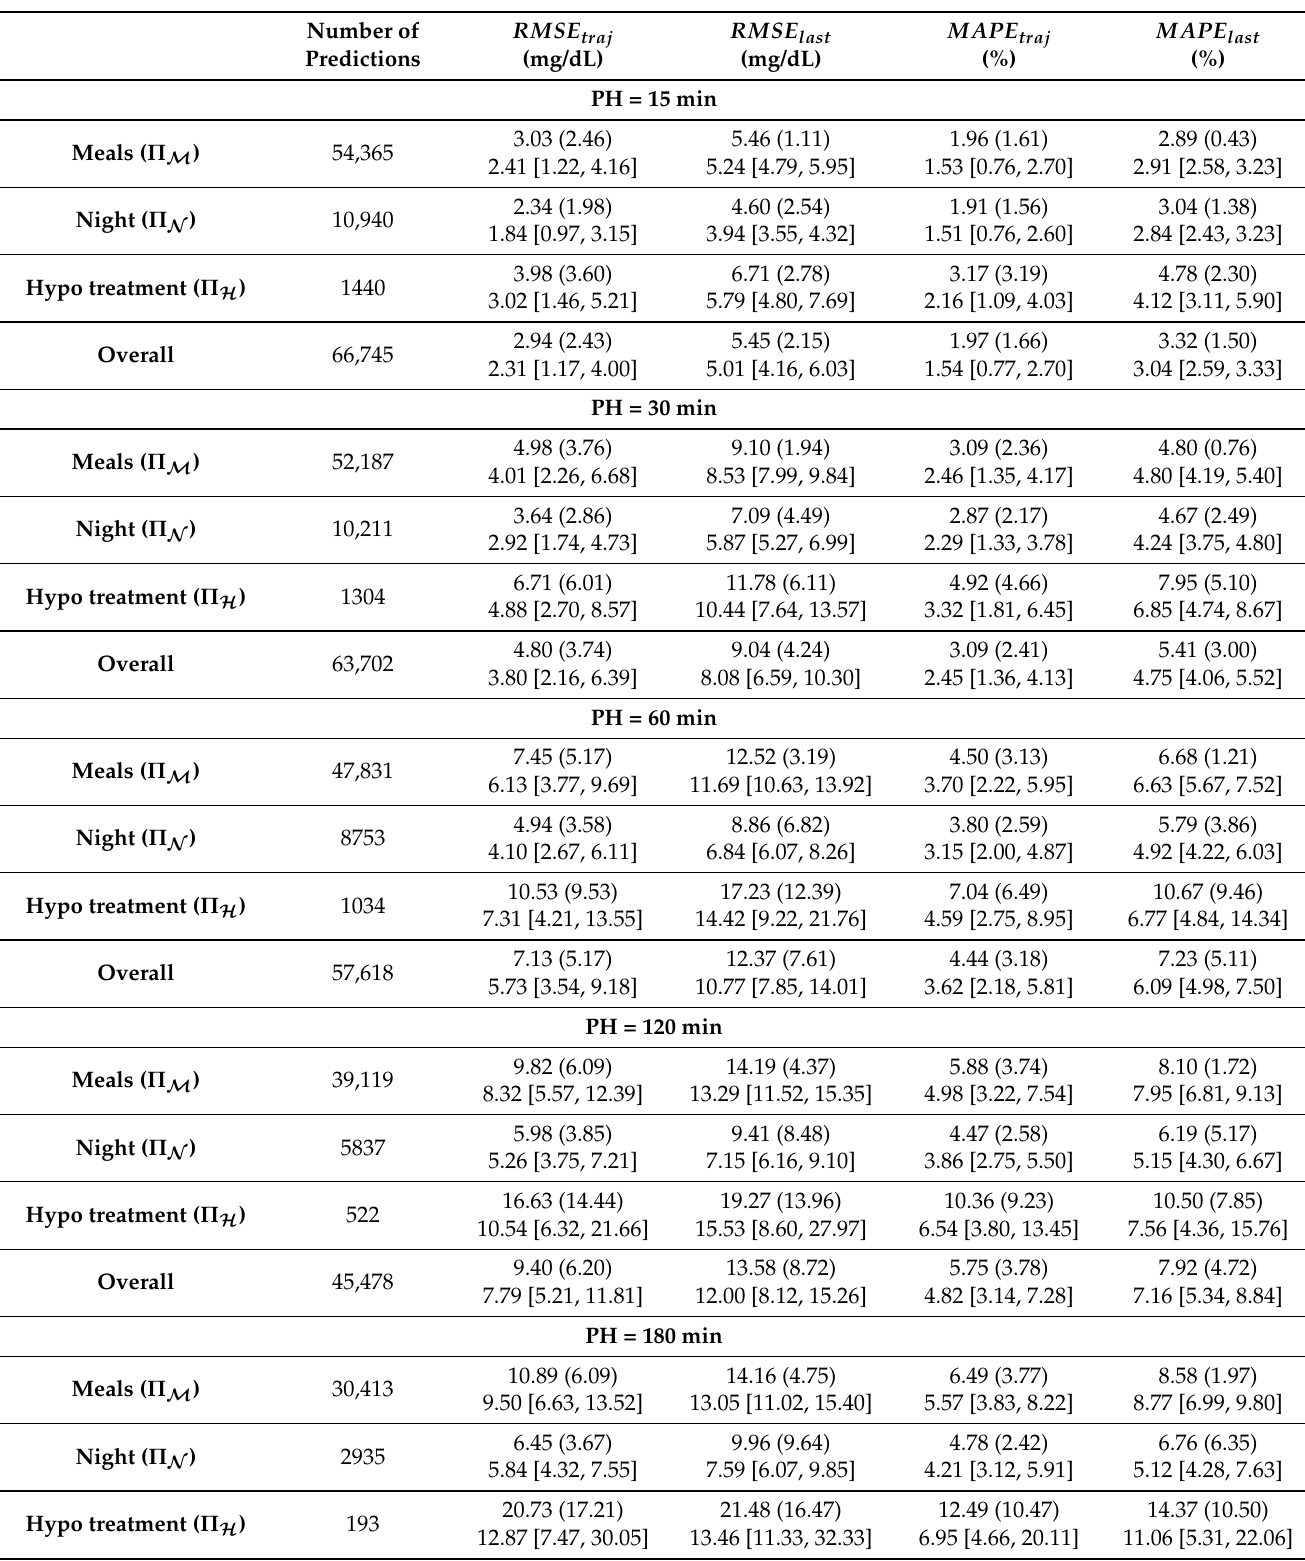
Table 4. Accuracy metrics of the trained local models aggregating data for all patients and local models in a partition, as well as overall metrics. The number of computed PH-ahead predictions is reported in each case, which depends on the number of validation events and their